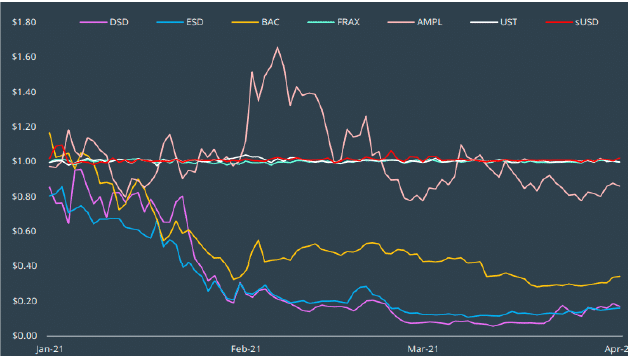
Figure 1. Comparison of peg stability of different stablecoins. Source: [6] Agent-Based